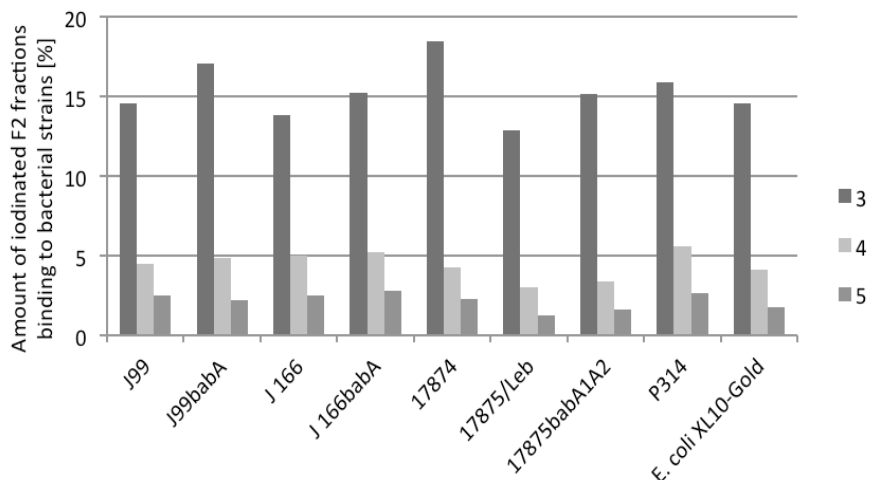
Figure 7. Binding of radiolabeled fractions of R. nigrum arabinogalactan protein F2 (subfractions FE3, 4 and 5) to different H. pylori bacterial strains and E. coli reference